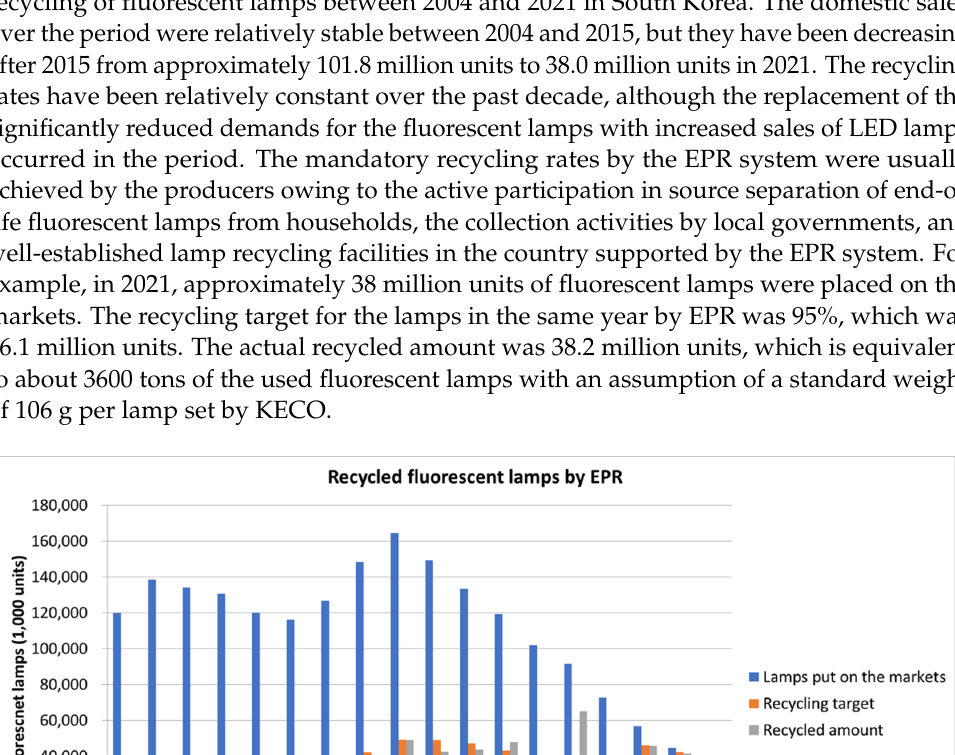
Figure 2. Collection, transportation, and recycling of end ‐ of ‐ life fluorescent lamps in South Korea.